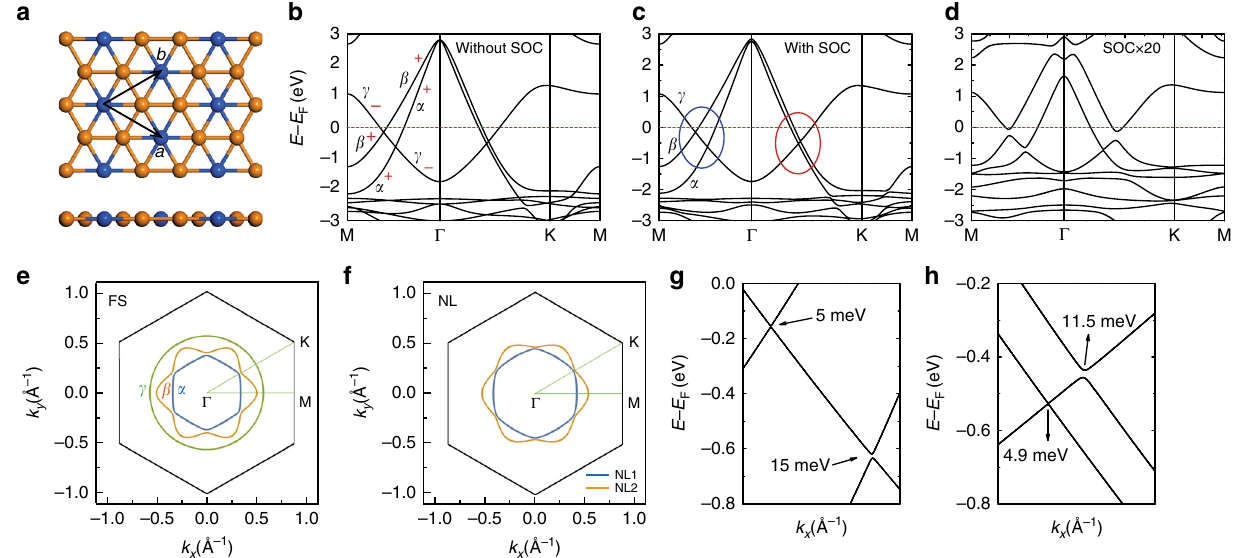
Fig. 1 Atomic and band structures of free-standing Cu 2 Si. a Top and side view. The orange and blue balls represent Cu and Si atoms, respectively. b , c Calculated band structures of Cu 2 Si without and with spin-orbit coupling (SOC), respectively. The vertical axis E - E F corresponds to - E B , where E B is the binding energy. For simplicity, we label the three bands that cross the Fermi level α , β , and γ , respectively. The parity of mirror re fl ection symmetry for each band is labelled plus and minus signs in b . The zoom-in band structures in the blue and red ellipses are shown in g , h . d Band structure of Cu 2 Si after arti fi cially increasing the intrinsic SOC by 20 times. e Fermi surface of Cu 2 Si without SOC. The blue, orange, and green lines correspond to bands α , β , and γ , respectively. f Momentum distribution of the nodal loops: NL1 (blue) and NL2 (orange). g , h Zoom-in band structures in the blue and red ellipses in c , which clearly show the SOC-induced